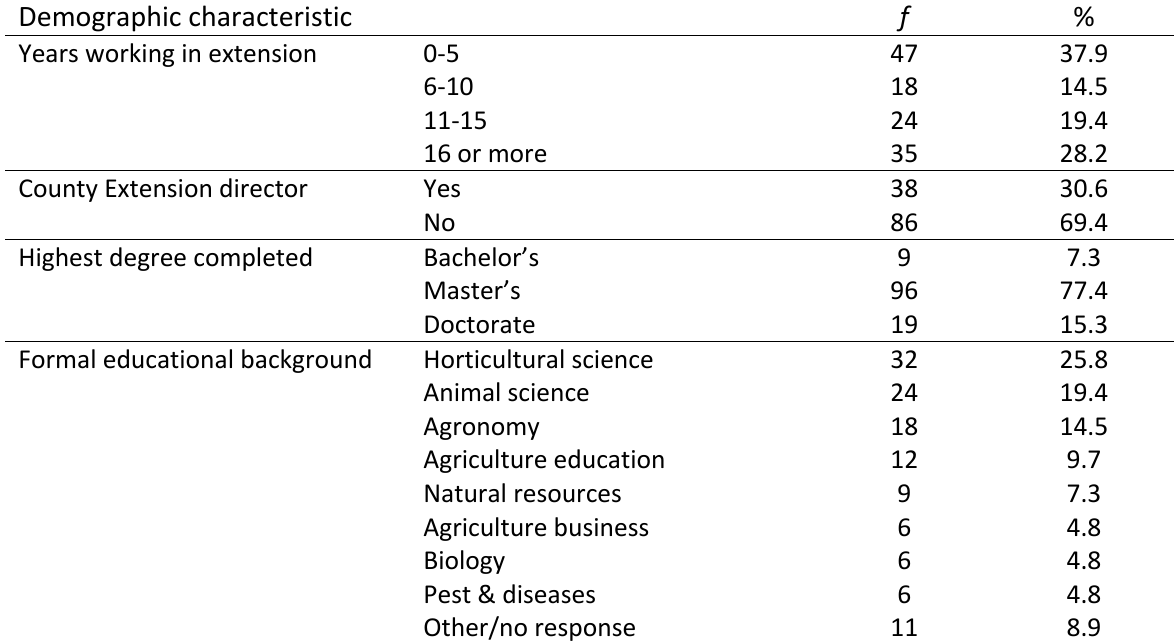
Demographic Characteristics of Survey Respondents Demographic